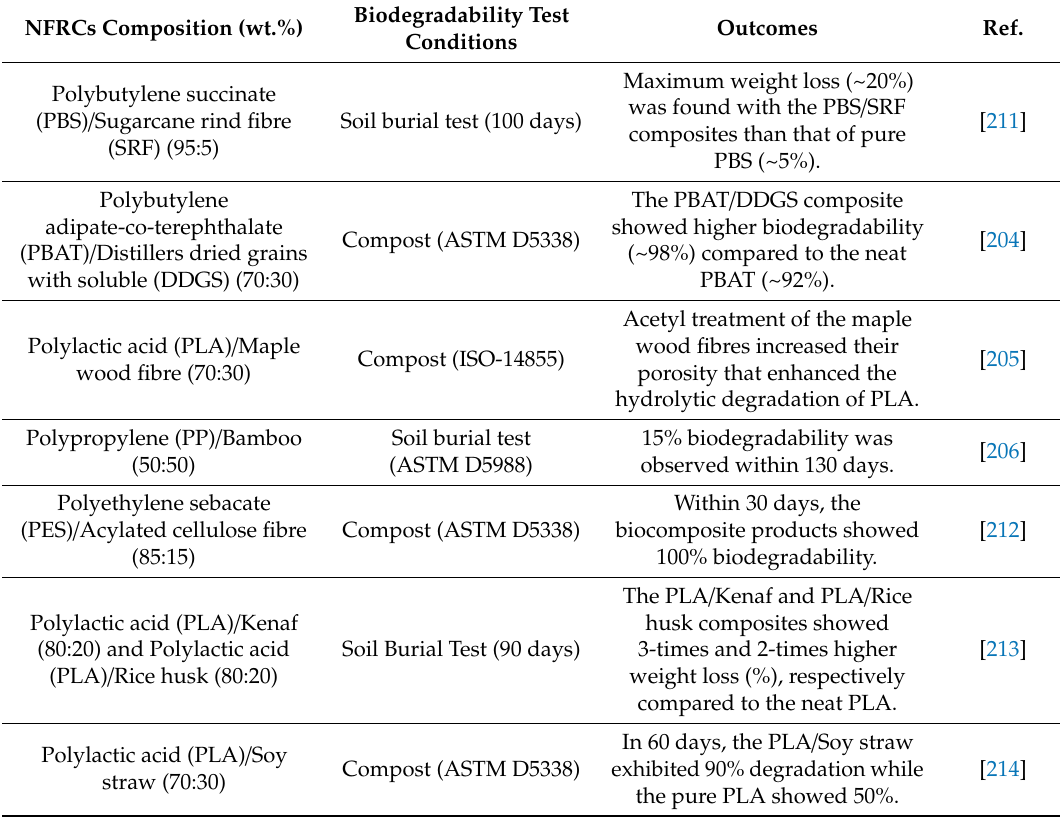
Table 5. Biodegradability of the natural fibre reinforced composites